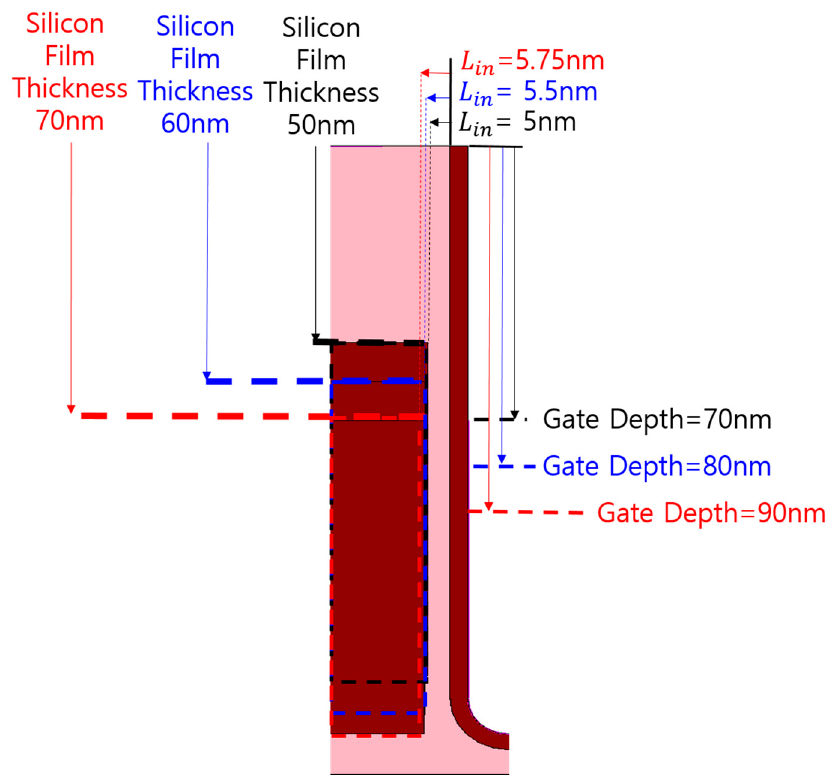
Figure 16. Optimal parameters (L in and silicon film thickness) in Pi-BCAT at gate depths = 70 nm, 80 nm and 90 nm.